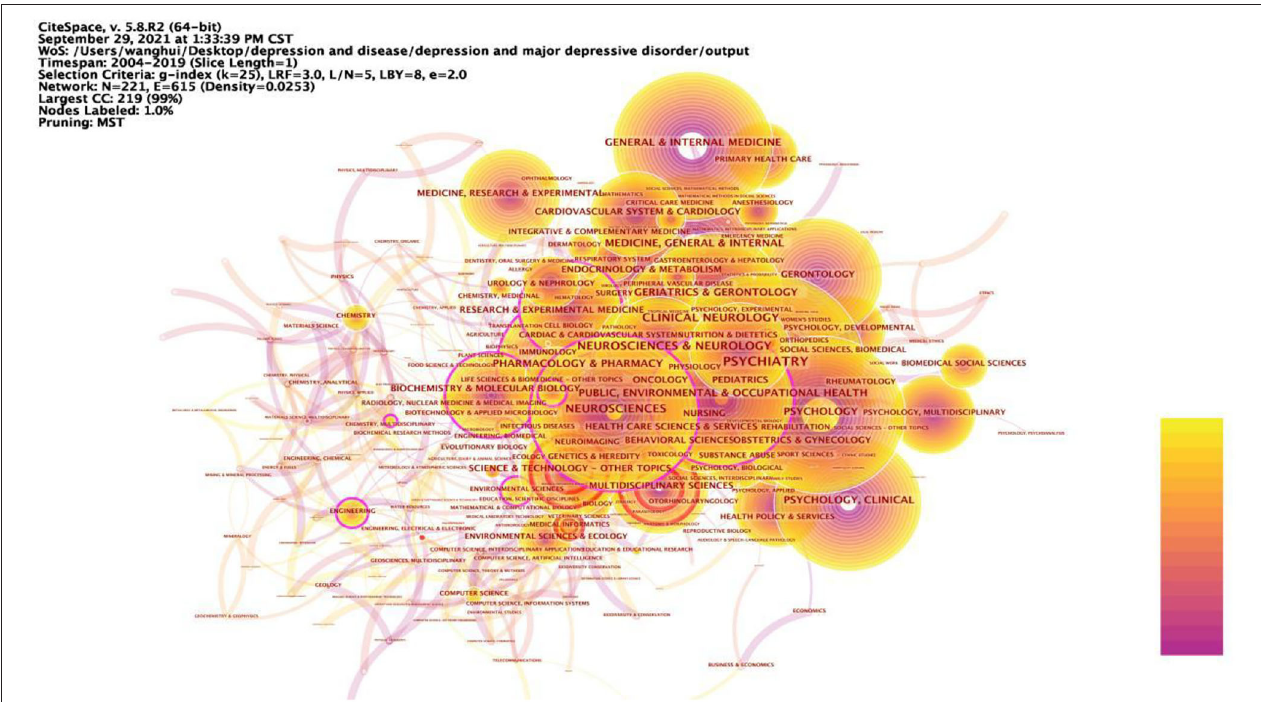
FIGURE 4 | Prominent categories involved in depression, 2004–2019. The betweenness centrality of a node in the network measures the importance of the position of the node in the network. Two types of nodes may have high betweenness centrality scores: (1) Nodes that are highly connected to other nodes, (2) Nodes are positioned between different groups of nodes. The lines represent the link between two different